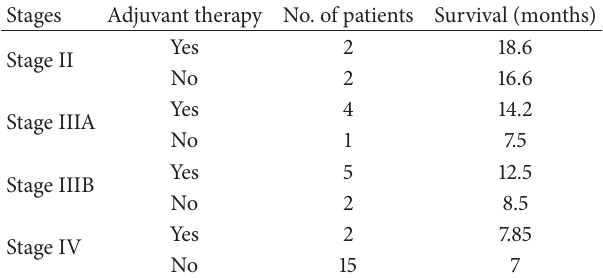
Table 1: Stage wise survival of studied subjects (young patients).